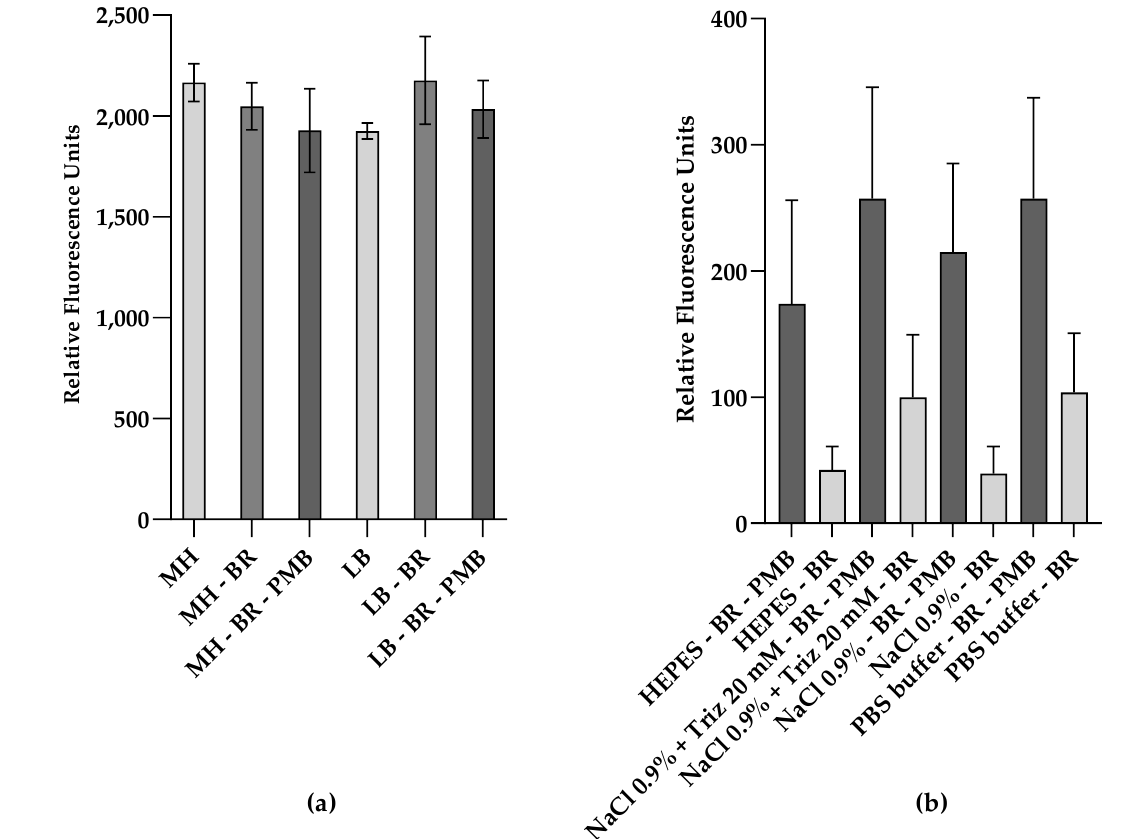
Figure 1. Relative fluorescence of UnaG in live E. coli cells is affected by the fluorescent background and the cell envelope active peptide polymyxin B (PMB). Relative fluorescence of E. coli MC4100 constitutively expressing UnaG from pMM001 after 15 min exposure to 5 µ M bilirubin (BR) and 10 µ g/mL of PMB in ( a ) MH medium or LB medium; ( b ) buffers and solutions, at an OD 600 of 0.5. Relative fluorescence values are blanked to the respective control without BR. Each data point is the mean of three independent measurements.